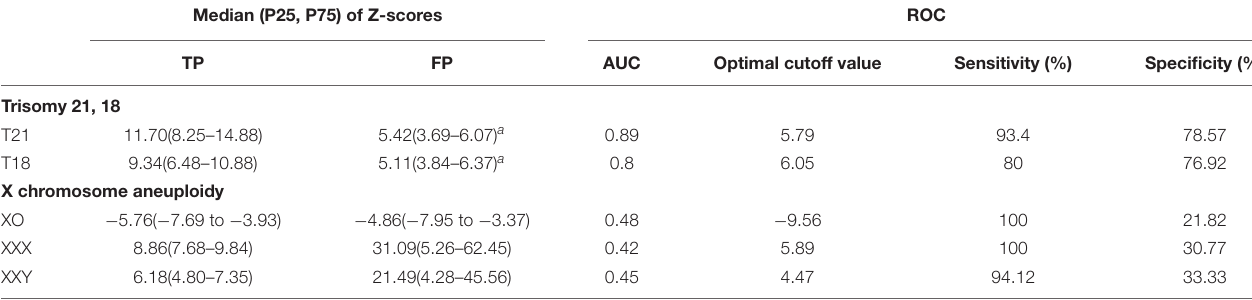
TABLE 3 | Distribution of Z-scores and receiver operating characteristic (ROC) curve analysis of pregnancies with T21, 18, and X chromosome aneuploidy.